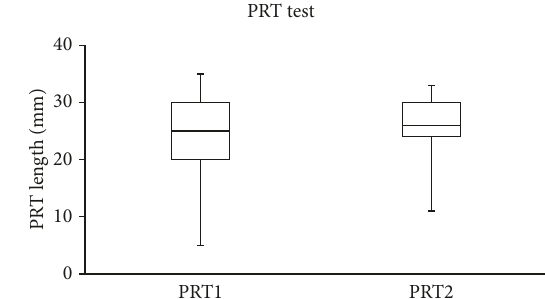
Figure 3: Side-by-side boxplots for the PRT scores for the study group before (PRT1) and after wearing (PRT2) a face